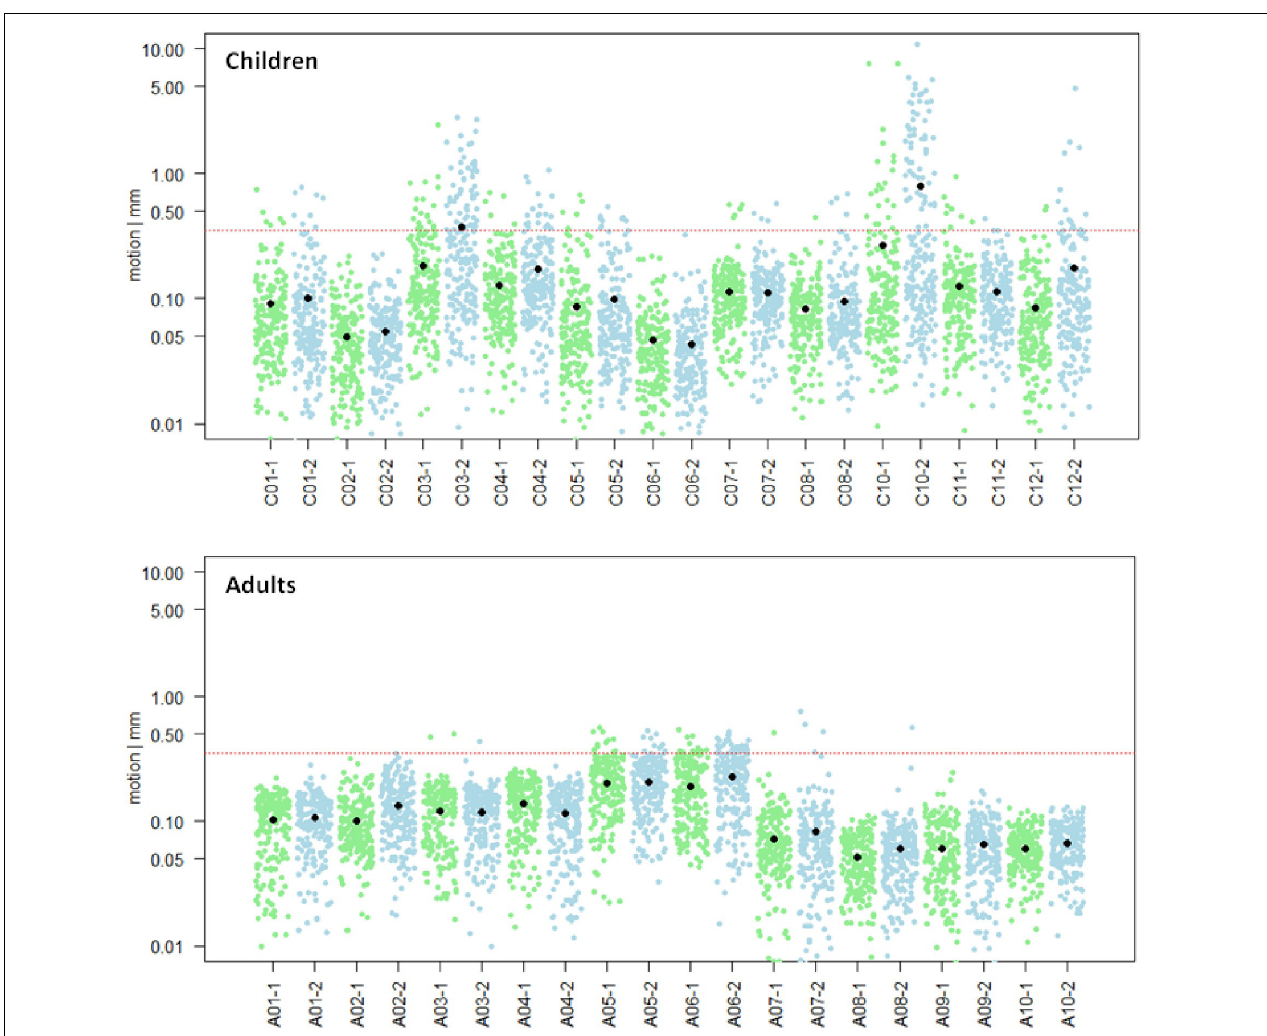
FIGURE 3 | Motion analysis. Mean scan-to-scan motion of the child ( n = 11, top ) and the adult ( n = 10, bottom ) sample, separately for each subject and each session. The first session is depicted in green, the second session in blue. On the x -axis, the subject and session are specified; on the y -axis, the mean scan-to-scan motion is given in logarithmic representation to show normal distribution of data points. The red line marks the cut-off score of a mean scan-to-scan motion threshold of 0.35 mm. The black dots represent the mean scan-to-scan motion. Child C03 and Child C10 were excluded from further analyses due to motion exceeding the predefined session-specific mean scan-to-scan motion threshold of > 0.35 mm in the second